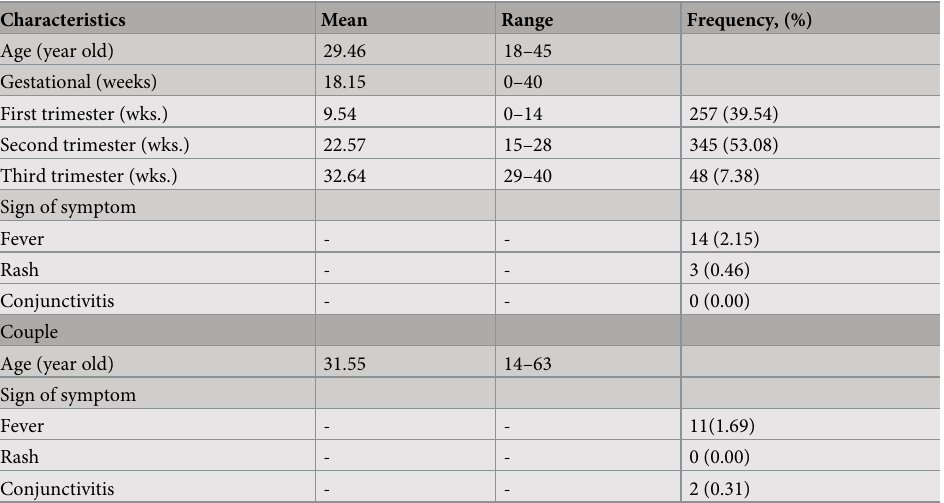
Table 1. Demographic data of pregnant women.